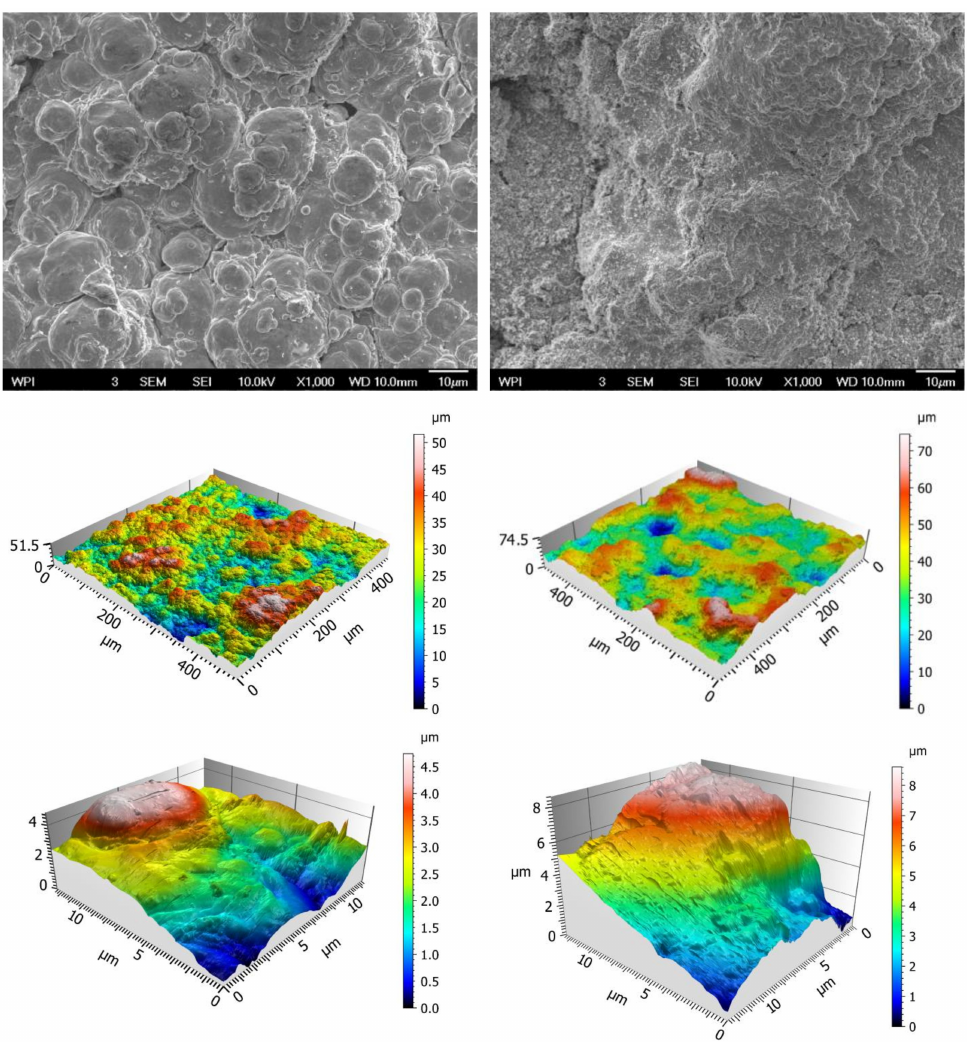
Figure 32. 3D confocal microscopy and SEM surface analysis. The left column of images concerns the conventional Cu cold spray coating while the right column of images corresponds with the nanostructured Cu